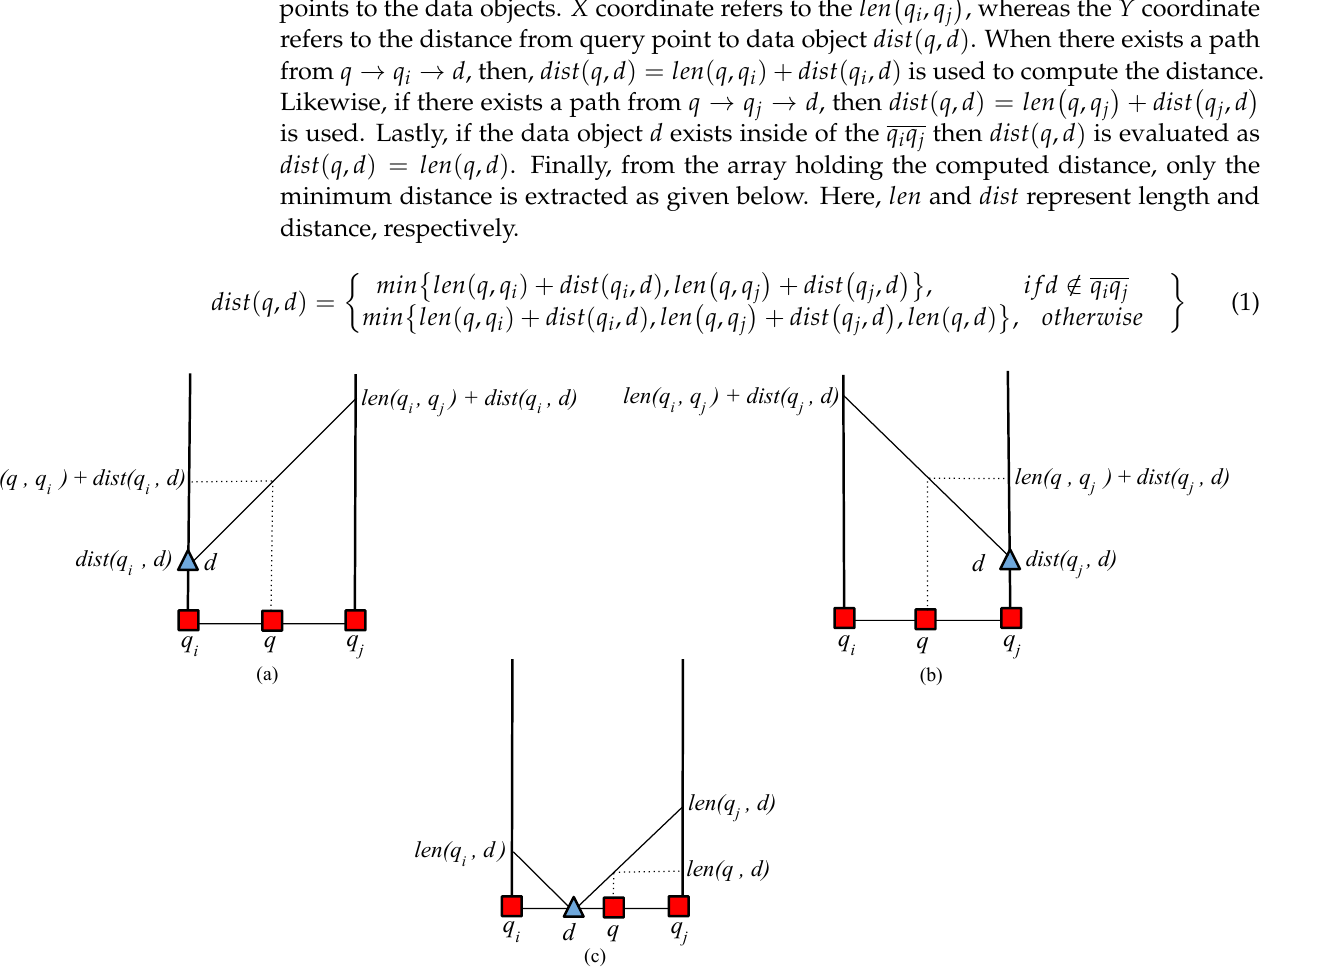
Figure 4. Conditions to compute the distance from q to d : ( a ) If d ∈ D q i , then dist ( q i , d ) = len ( q , q i ) + dist ( q i , d ) ; ( b ) If d ∈ D q j , (cid:16) (cid:17) (cid:16) (cid:17) (cid:16) (cid:17) (cid:16) (cid:17) = len + dist q j , d q j , d q , q j q i q j ; ( c ) If d ∈ , then dist ( q , d ) = len ( q , d ) then dist